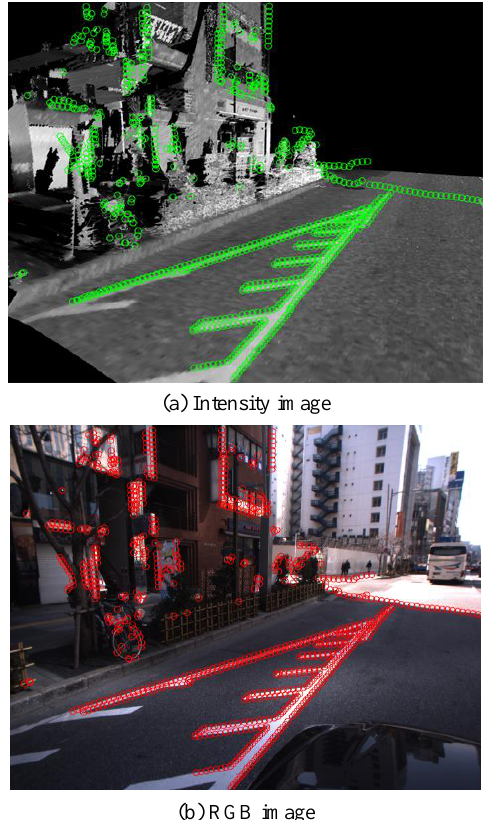
Figure 18. Correspondence of edge features